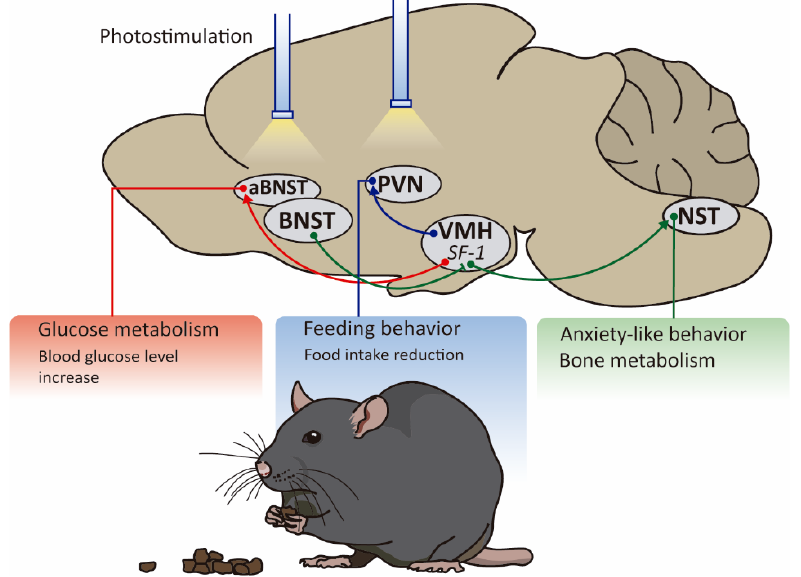
Figure 5. Neurocircuitry linking SF1 VMH neurons to other brain areas in energy balance. Using optogenetic tools, the paraventricular nucleus of the hypothalamus (PVN) has been identified as a downstream target nucleus underlying the SF1 suppression of food intake. Downstream projections of SF1 in the VMH involved in the control of glycemia are the bed nucleus of the stria terminalis (aBNST) since photostimulation of the VMH Sf1 -aBNST circuit leads to increases in blood glucose levels. Finally, SF1 neurons are innervated by upstream BNST neurons and send projection to the nucleus tractus solitarius (NST) to regulate anxiety-like behavior and bone metabolism.